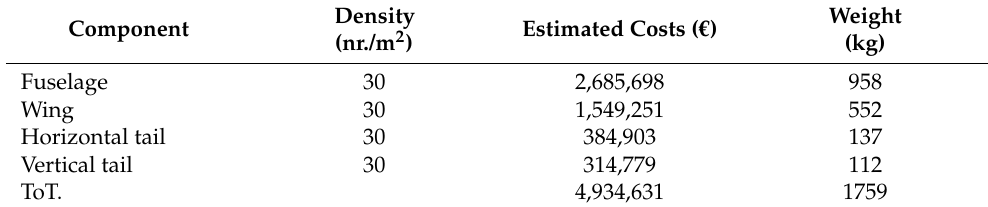
Table 8. SHM system characteristics.